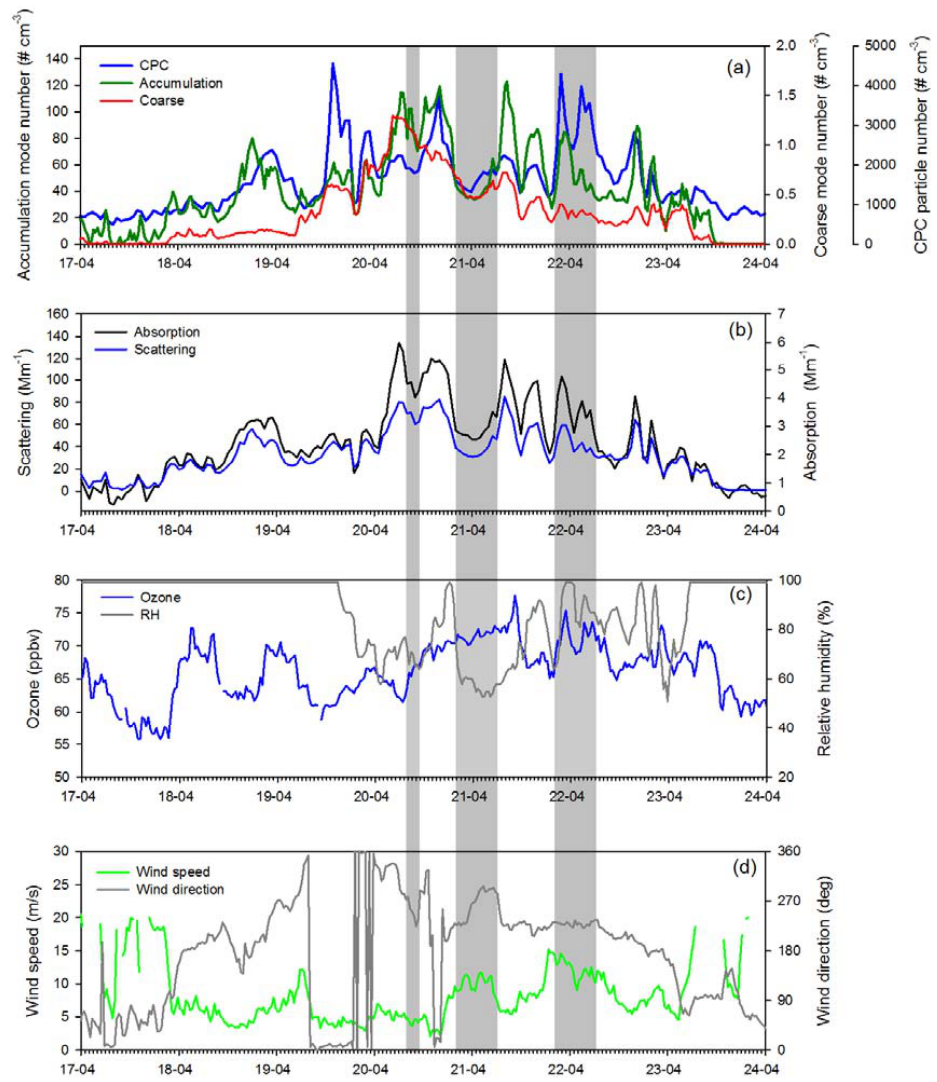
Fig. 3. April 2010: time series of (a) particle concentration (cm − 3 ) in the CPC, accumulation and coarse mode; (b) absorption and scattering Figure 3. April 2010: Time series of (a) particle concentration (cm-3) in the CPC, 2 coefficient; (c) surface ozone and relative humidity; and (d) wind speed and wind direction. The time periods covered by samples for chemical analyses are accumulation and coarse mode, (b) absorption and scattering coefficient, (c) surface ozone 3 and relative humidity and (d) wind speed and wind direction. The time periods covered by 4 samples for chemical analyses are shaded.5